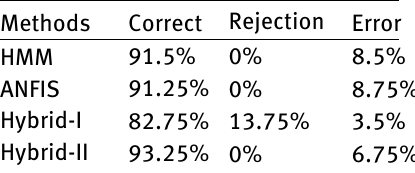
Table 2: Average results of 8 folds CV accuracy of Hybrid systems